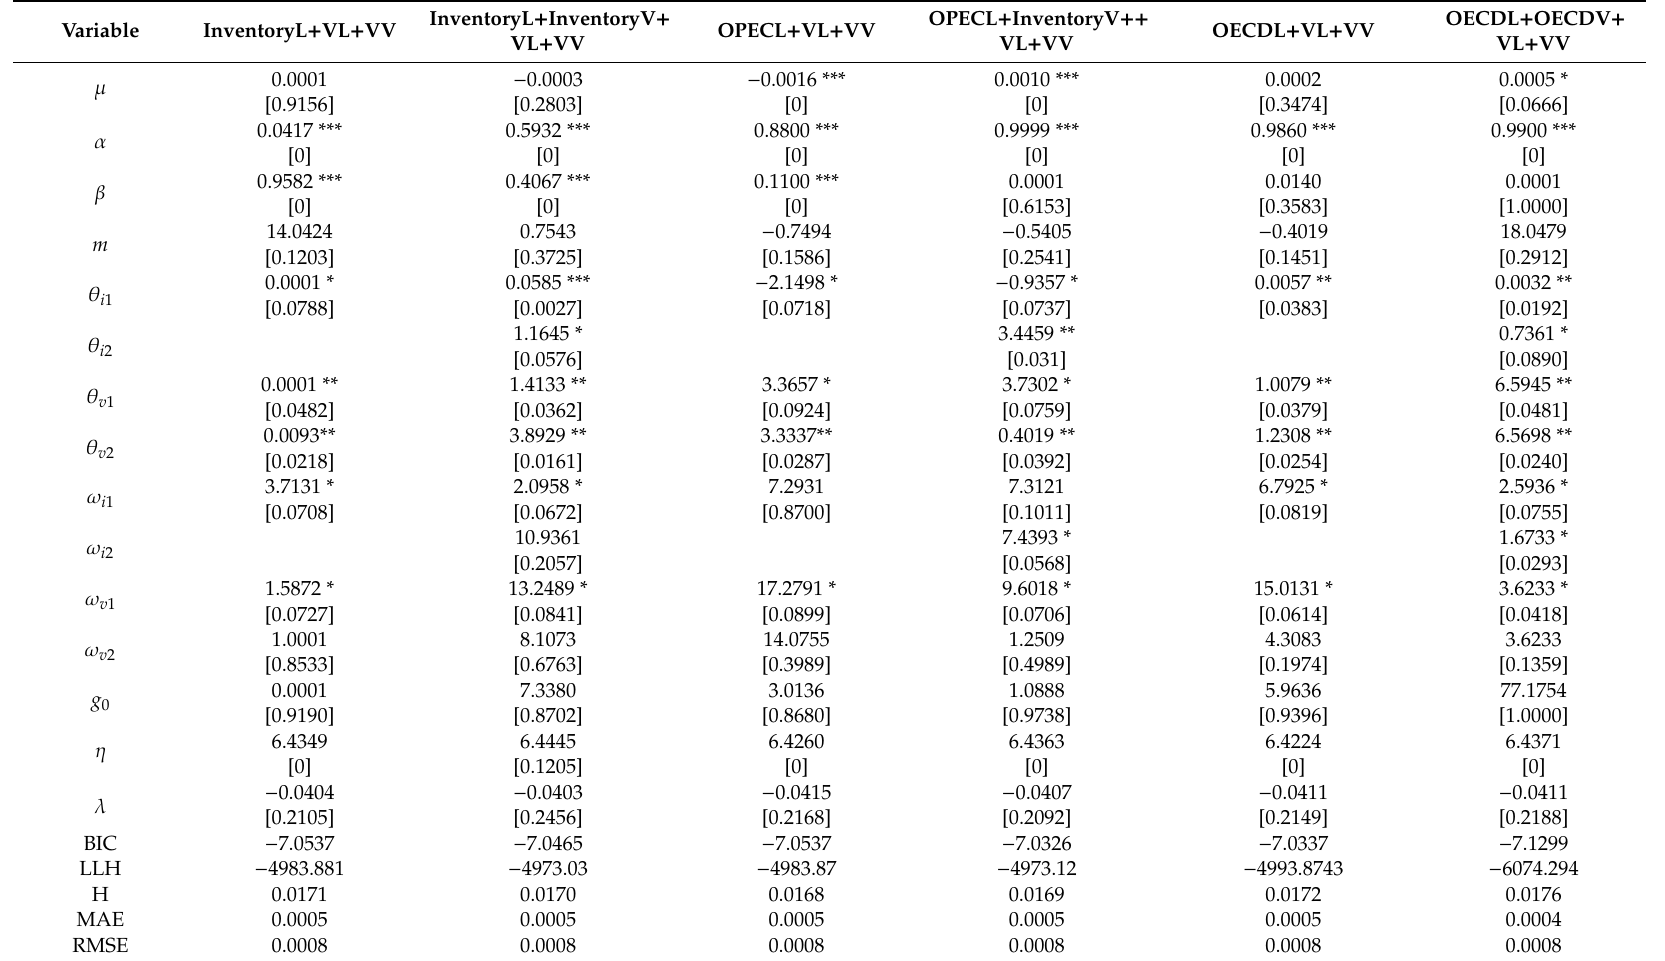
Table 11. Estimation results of associative e ff ect model of high-frequency factors and low-frequency